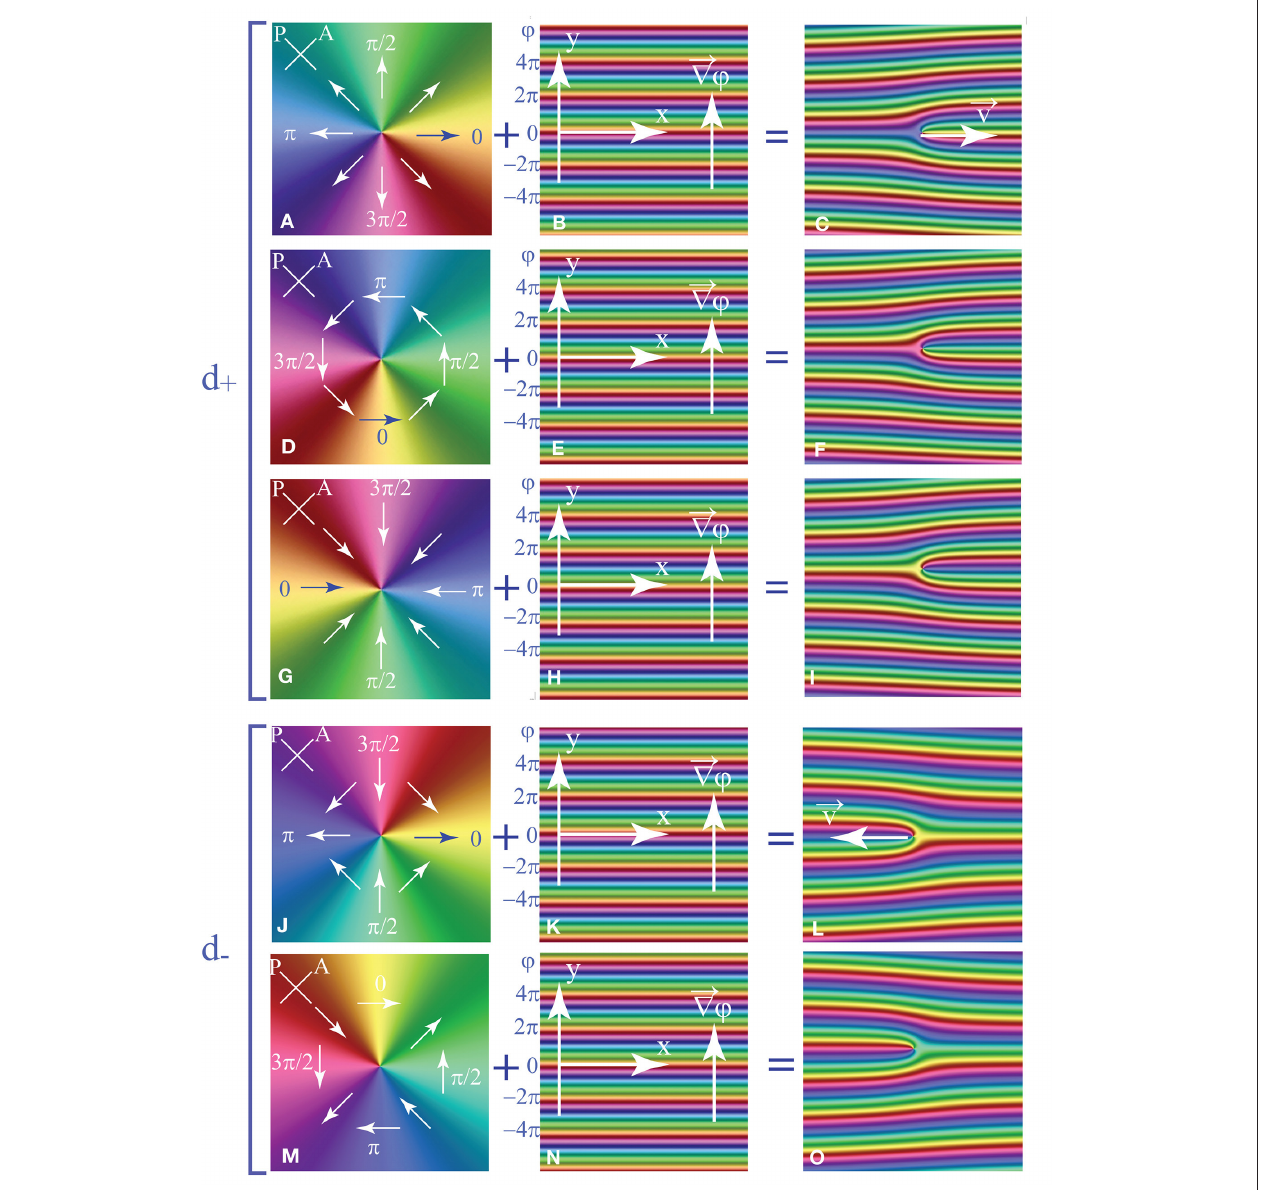
FIGURE 2 | (A–I) Dowson +2 π imbedded in a wound up dowser texture. (A,D,G) Radial, orthoradial, and antiradial configurations of the dowson d + alone. The orthoradial configuration has the lowest elastic energy [5]. (B,E,H) Phase field of the dowser texture wound up in y direction: ϕ = 2 π y /λ . (C,F,I) The wound up phase field with the dowson d + imbedded respectively at y = 0 (C) , y = λ /4 (F) , and y= λ /2 (I) . (J–O) Dowson -2 π imbedded in a wound up dowser texture. (J,M) Configurations of the dowson d − depend on the phase ϕ i = ϕ ( x i , y i ) at the insertion point ( x i , y i ). They result from rotation by the angle ϕ i . (K,N) Phase field of